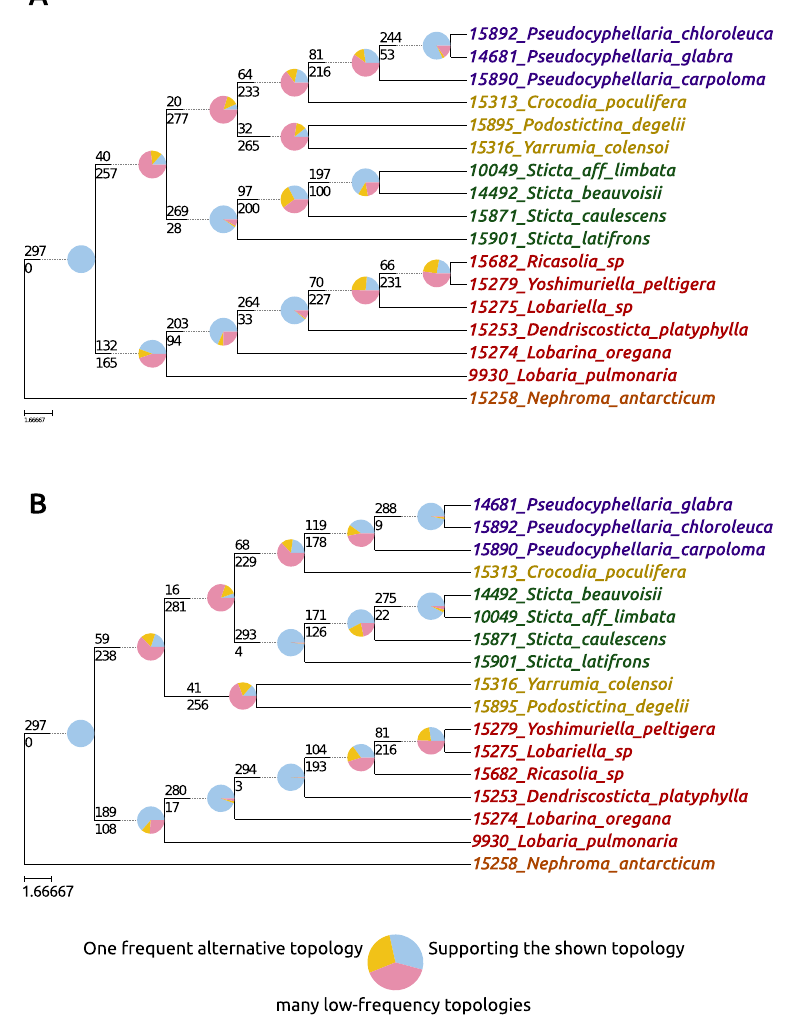
Figure 4. ASTRAL species trees. ( A ) Estimated with the 297 amino acid trees. ( B ) Estimated with 297 nucleotide trees. Pie charts show the gene tree conflict evaluation at each node with light blue proportions representing concordant topologies, pink portions representing conflicting topologies, and yellow proportions representing one dominant alternative topology. Numbers above the branches report the number of gene trees supporting that node, while the number below reports the number that are in